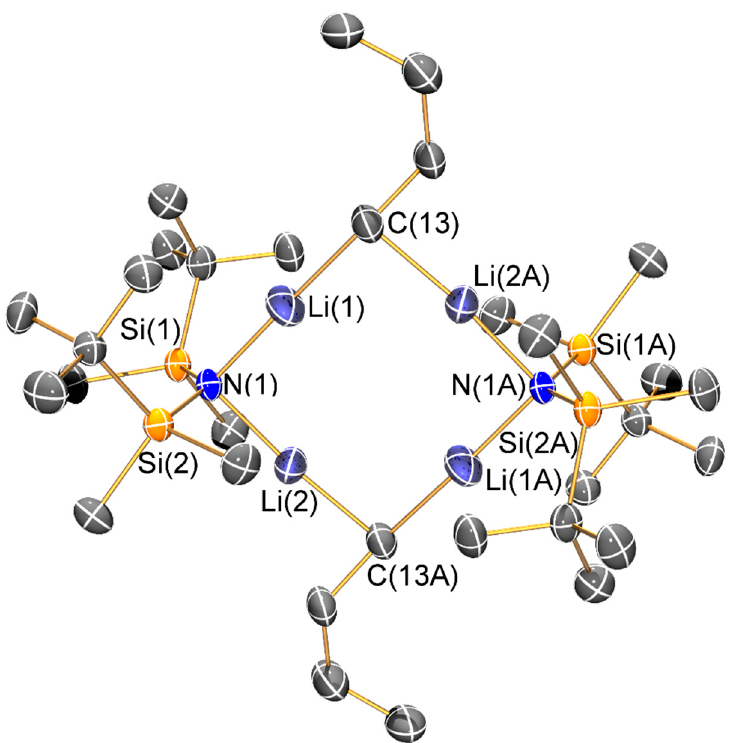
Figure 5. Molecular structure of [Li 2 { μ -N(Si t BuMe 2 ) 2 }( μ - n Bu)] 2 ( 5 ) with selective atom labelling. Displacement ellipsoids set at 30% probability level and hydrogen atoms omitted for clarity. Symmetry operation to generate equivalent atoms: x , y , z .